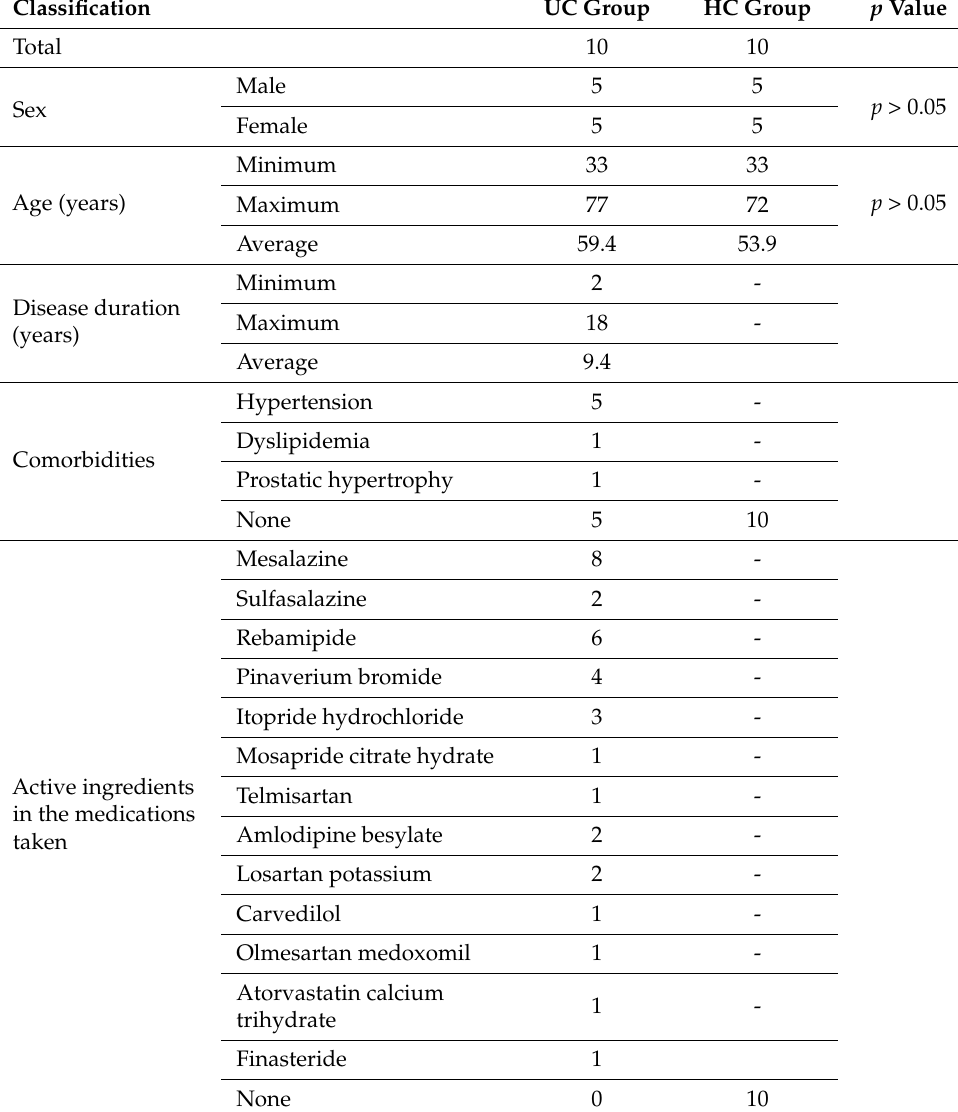
Table 1. Demographic characteristics and medical history of enrolled